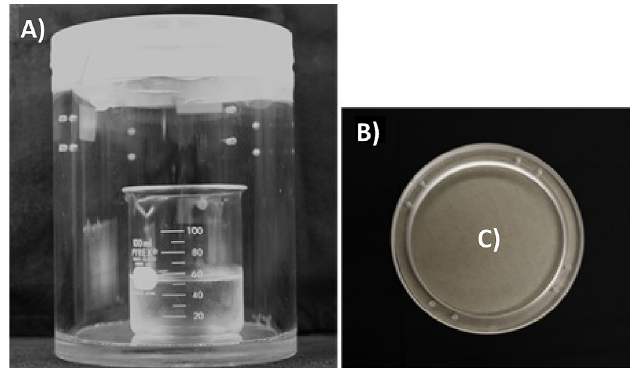
Fig. 1: Method for evaluation of the water vapour barrier property of corru- gated boards. A) Gas-tight chamber containing a beaker with 50 mL of water. B) Top view of the assembly. C) Disc of corrugated board.